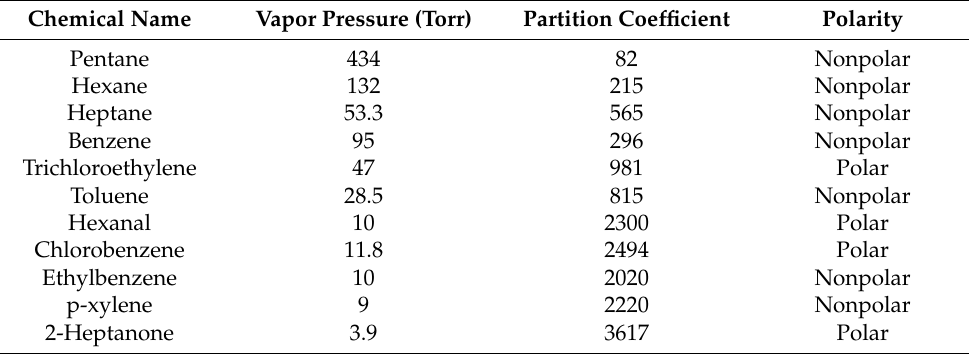
Table 1. Characteristics of the analytes at room